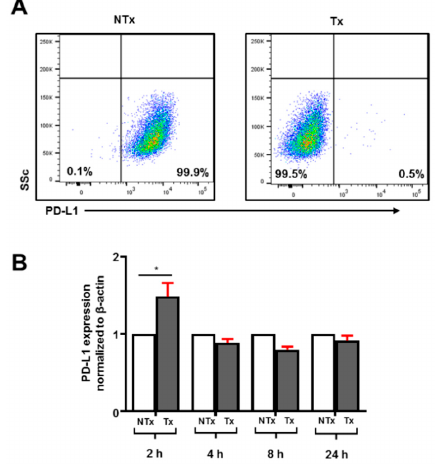
Figure 1. Effect of atezolizumab on PD-L1 expression on MDA-MB-231 cells. MDA-MB-231 cells were cultured in the presence or absence of atezolizumab for up to 24 h to investigate the effect of PD-L1 blockade on the surface and transcriptomic expression of PD-L1. Representative flow cytometric plots show PD-L1 expression on non-treated (NTx) and treated (Tx) MDA-MB-231 cells ( A ). The bar plot shows differences in PD-L1 transcriptomic expression in MDA-MB-231 cells up to 24 h Tx with atezolizumab ( B ).